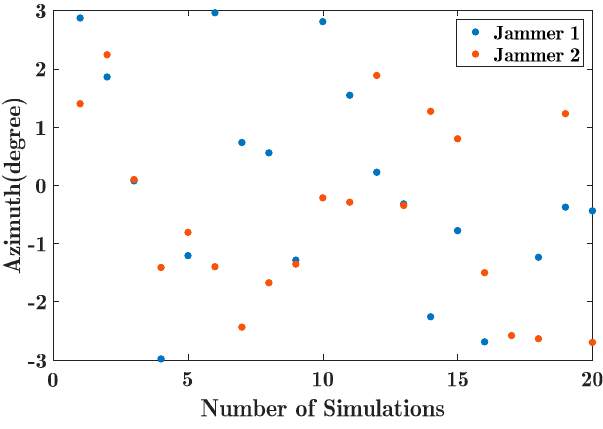
Figure 12. The randomized jamming environment.